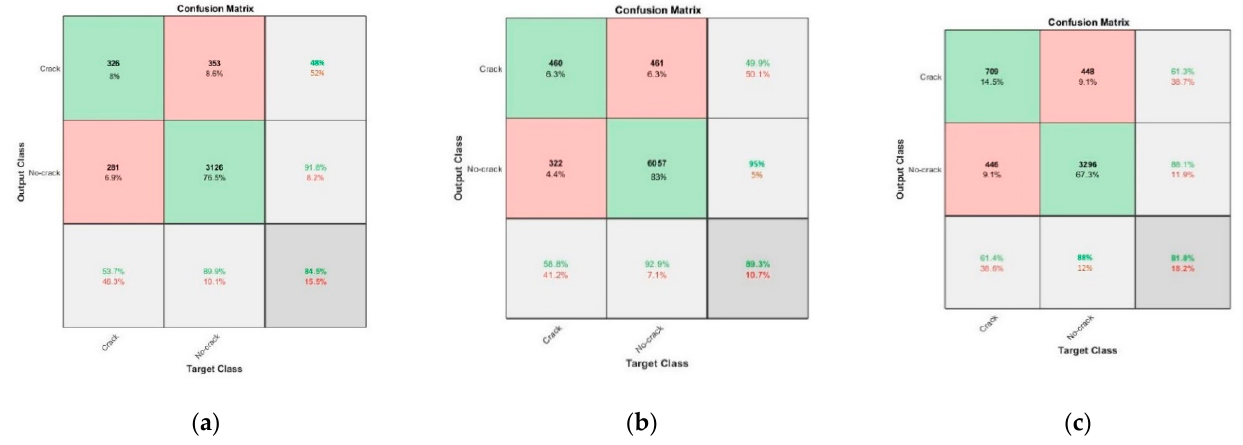
Figure 10. Confusion matrices of the cross-dataset images: ( a ) bridge-decks; ( b ) pavements; ( c ) walls. Table 8. Performance metrics of cross-dataset test results.